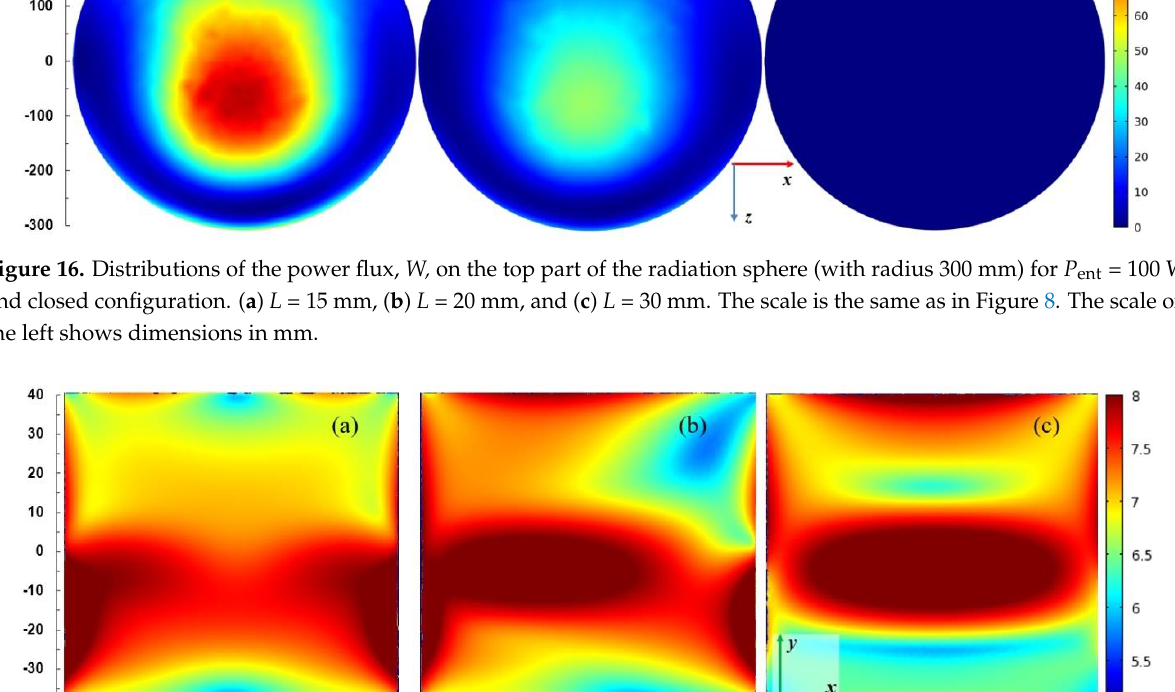
Figure 17. Spatial distributions of the log 10 of Q rh /(1 Wm −3 ) in x - y plane passing through the center of the plasma for P ent = 100 W and closed configuration. ( a ) L = 15 mm, ( b ) L = 20 mm, and ( c ) L = 30 mm. The scale is the same as in Figure 9. The scale on the left shows dimensions in mm.